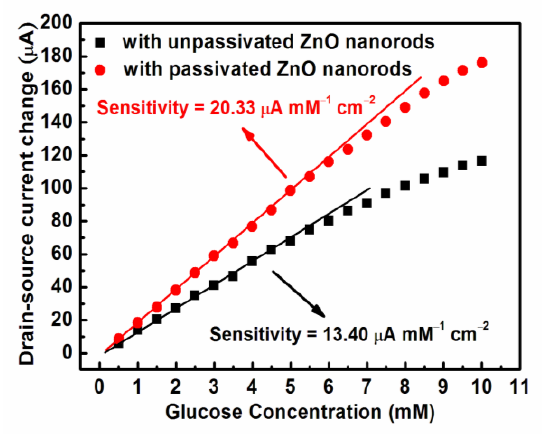
Figure 6. Drain-source current change as a function of glucose concentration of the unpassivated and the passivated glucose